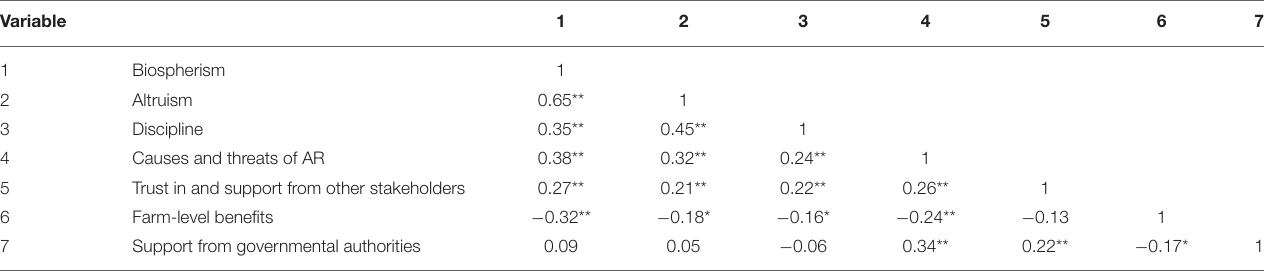
TABLE 5 | Correlation matrix (Spearman’s rho) of personal value and perception variables for inclusion in the multivariable logistic regression model on the probability of feeding waste milk containing antibiotic residues to calves. Variable